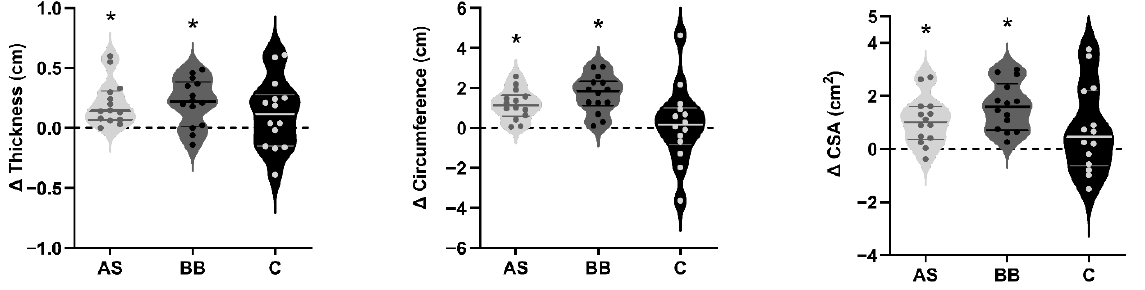
Figure 4. The violin plots of changes in the thickness, circumference, and cross-sectional area (CSA) of the rectus femoris (RF) in AS, BB, and C group after 6-week intervention. The thick solid lines indicate the mean value of changes of each group, and the thin solid lines indicate interquartile range. An asterisk (*) indicates the change of the index is significant ( p < 0.05).